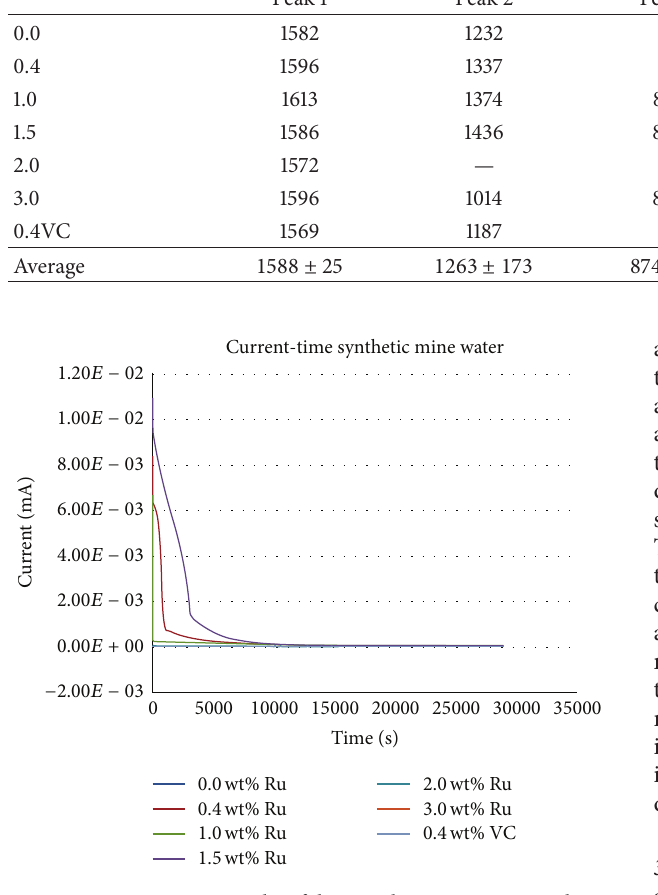
Figure 8: Current-time results of the samples exposure to synthetic mine water at an applied potential of 700 mV versus Ag/AgCl reference